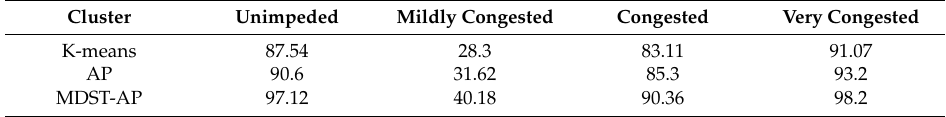
Table 6. Accuracy ratio of the points matched (ARP) comparison of the K-means, AP, and MDST-AP algorithms (%).